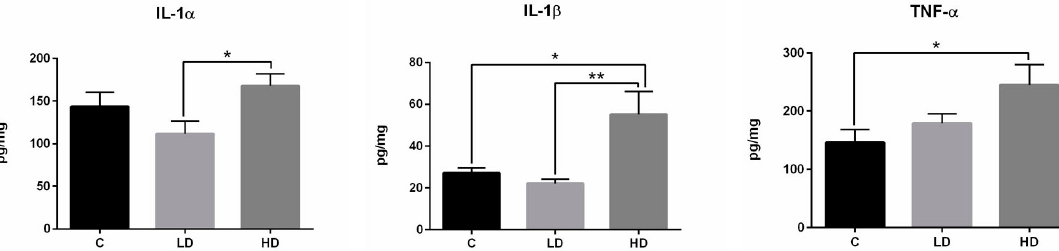
Figure 6. The concentration of the selected pro-inflammatory cytokines in the ileal Payer’s patches in control animals (C) and under low (LD) and high (HD) doses of BPA. Statistically significant ( p ≤ 0.05) and highly statistically significant ( p ≤ 0.01) differences between C group and LD group, C group and HD group, as well as LD group and HD group, are marked with * and **, respectively.